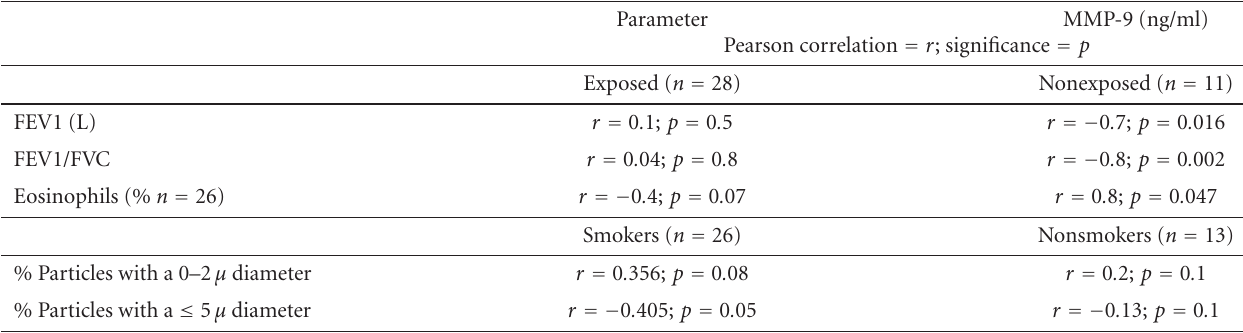
Table 3: Correlation of di ff erent parameters with MMP-9 (ng/ml) secretion among exposed and nonexposed workers.